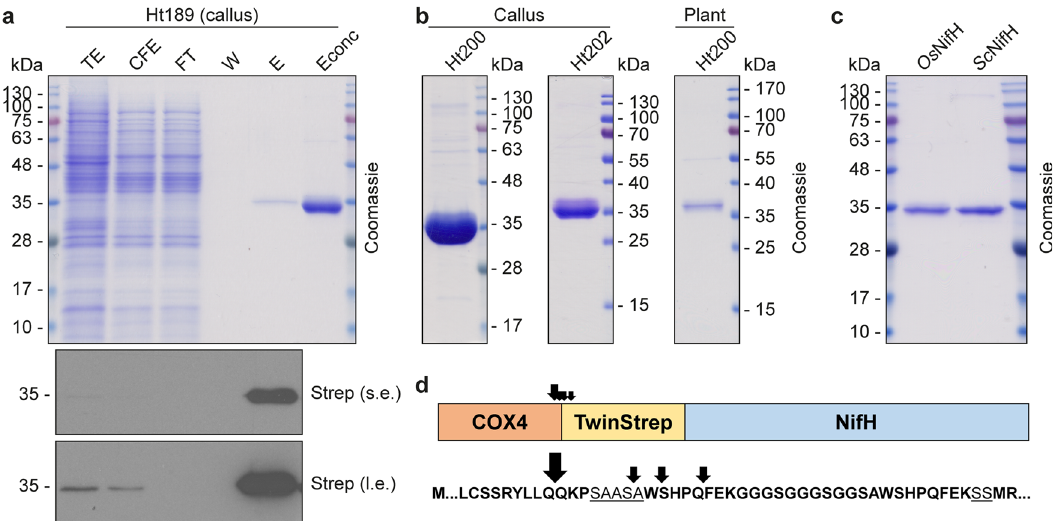
Fig. 2 STAC puri fi cation of Os NifH Ht protein targeted to rice mitochondria. a Puri fi cation of Os NifH Ht from Ht189 callus. Fractions were analyzed by SDS- PAGE followed by Coomassie staining or immunoblotting. TE total extract, CFE soluble cell-free extract, FT fl ow-through fraction, W wash fraction, E elution fraction. Econc concentrated elution fraction ( fi nal sample collected). s.e. short exposure, l.e. long exposure. Uncropped immunoblot analysis for the puri fi cation processes are shown in Supplementary Fig. 11. b Final Os NifH Ht sample isolated from Ht200 and Ht202 callus lines, and Ht200 rice plants. Uncropped Coomassie gels and immunoblot analysis for the puri fi cation processes are shown in Supplementary Fig. 3. c Side-by-side comparison of NifH Ht migration when isolated from Ht189 callus ( Os NifH Ht ) or yeast ( Sc NifH Ht ). d N-terminal sequencing of Os NifH Ht isolated from Ht189 callus. The deduced Cox4 mitochondrial targeting peptide processing sites are indicated with arrows (the dominant processing size indicated by a larger arrow). The underlined sequences indicate peptide linkers between the Cox4 signal and the TS-tag (SAASA), and between the TS-tag and Os NifH Ht (SS).